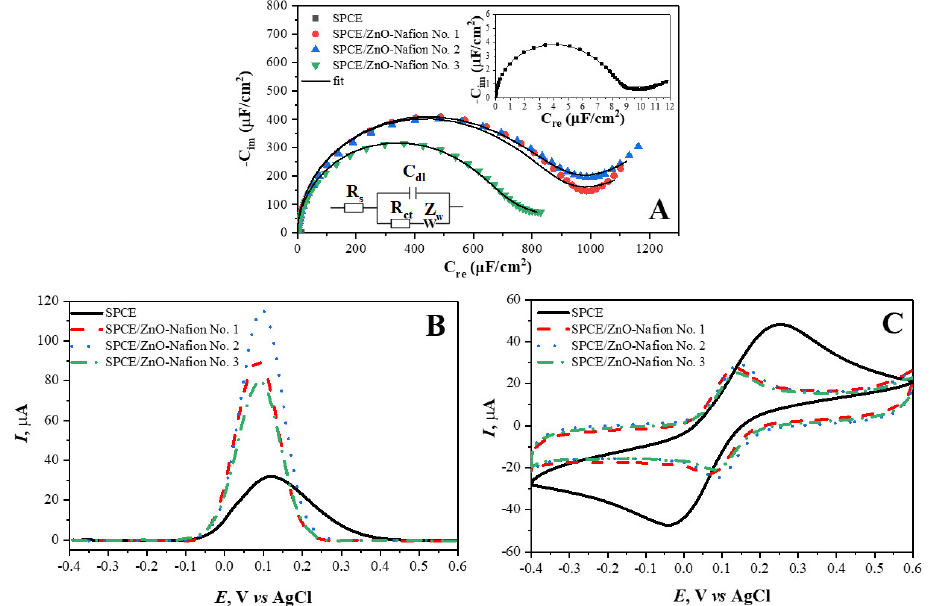
Figure 5. The Cole–Cole plot of EIS spectra ( A ), cyclic voltammograms ( B ), and differential pulse voltammograms ( C ) of SPCE (—), SPCE/ZnO-Nafion No. 1 (- - -), SPCE/ZnO-Nafion No. 2 (· · ·), and SPCE/ZnO-Nafion No. 3 (— ·). Bias potential for EIS 0 V vs. Ag/AgCl, amplitude 10 mV. Potential ranges from −0.4 to +0.6 V, CV scan rate 0.05 V/s, DPV step size of 4 mV, pulse height of 0.05 V, pulse period of 100 ms, pulse width of 50 ms. EIS measurements were performed in 0.01 M PBS, pH 7.4, CV and DPV measurements were performed in 0.01 M PBS, pH 7.4, containing 2.5 mM [Fe(CN 6 )] 3−/4− .